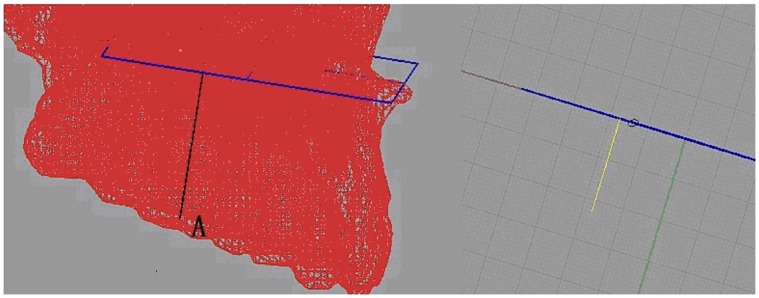
Dental measurements system.A is the crown central fossa (the very low point of fossa).